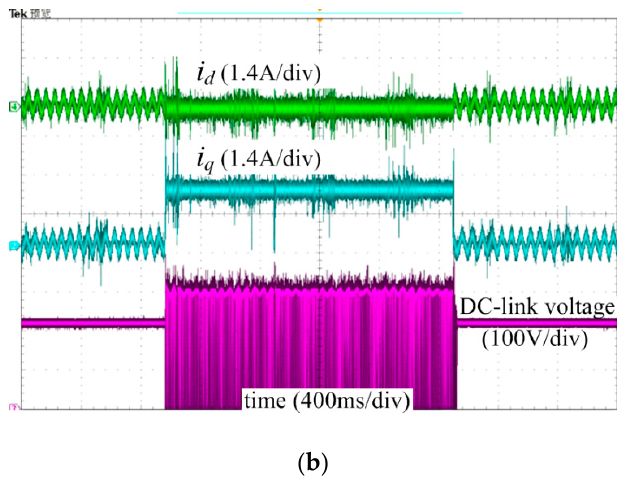
Figure 8. d - and q -axis current and DC-link voltage with different strategies: ( a ) Flux-weakening strategy; ( b ) Voltage boosting strategy.